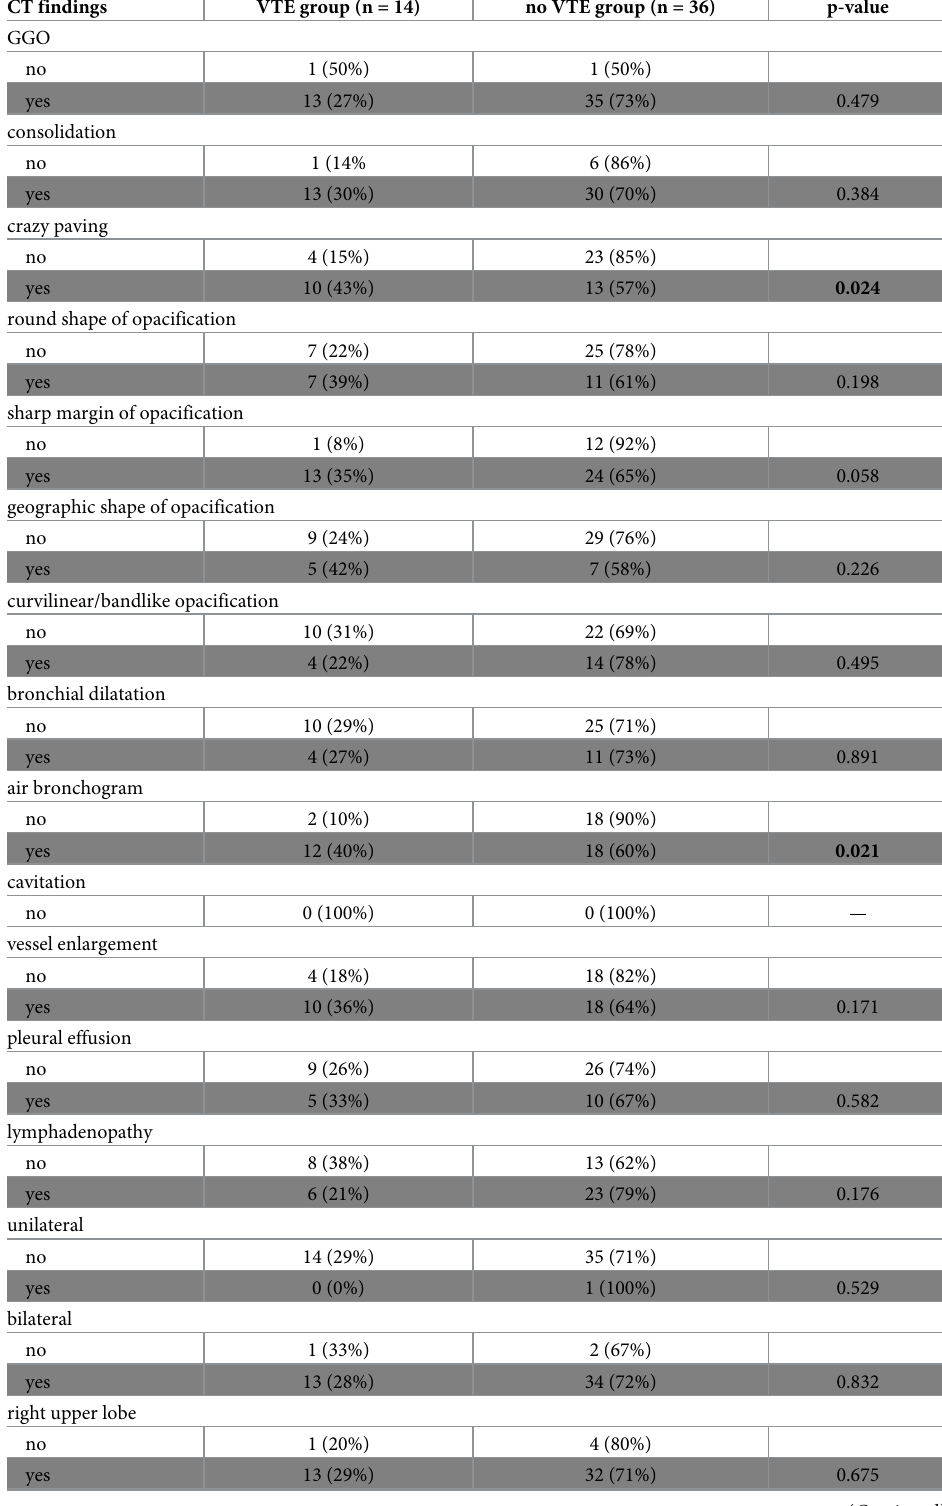
Table 5. Differences between VTE vs. no VTE regarding CT